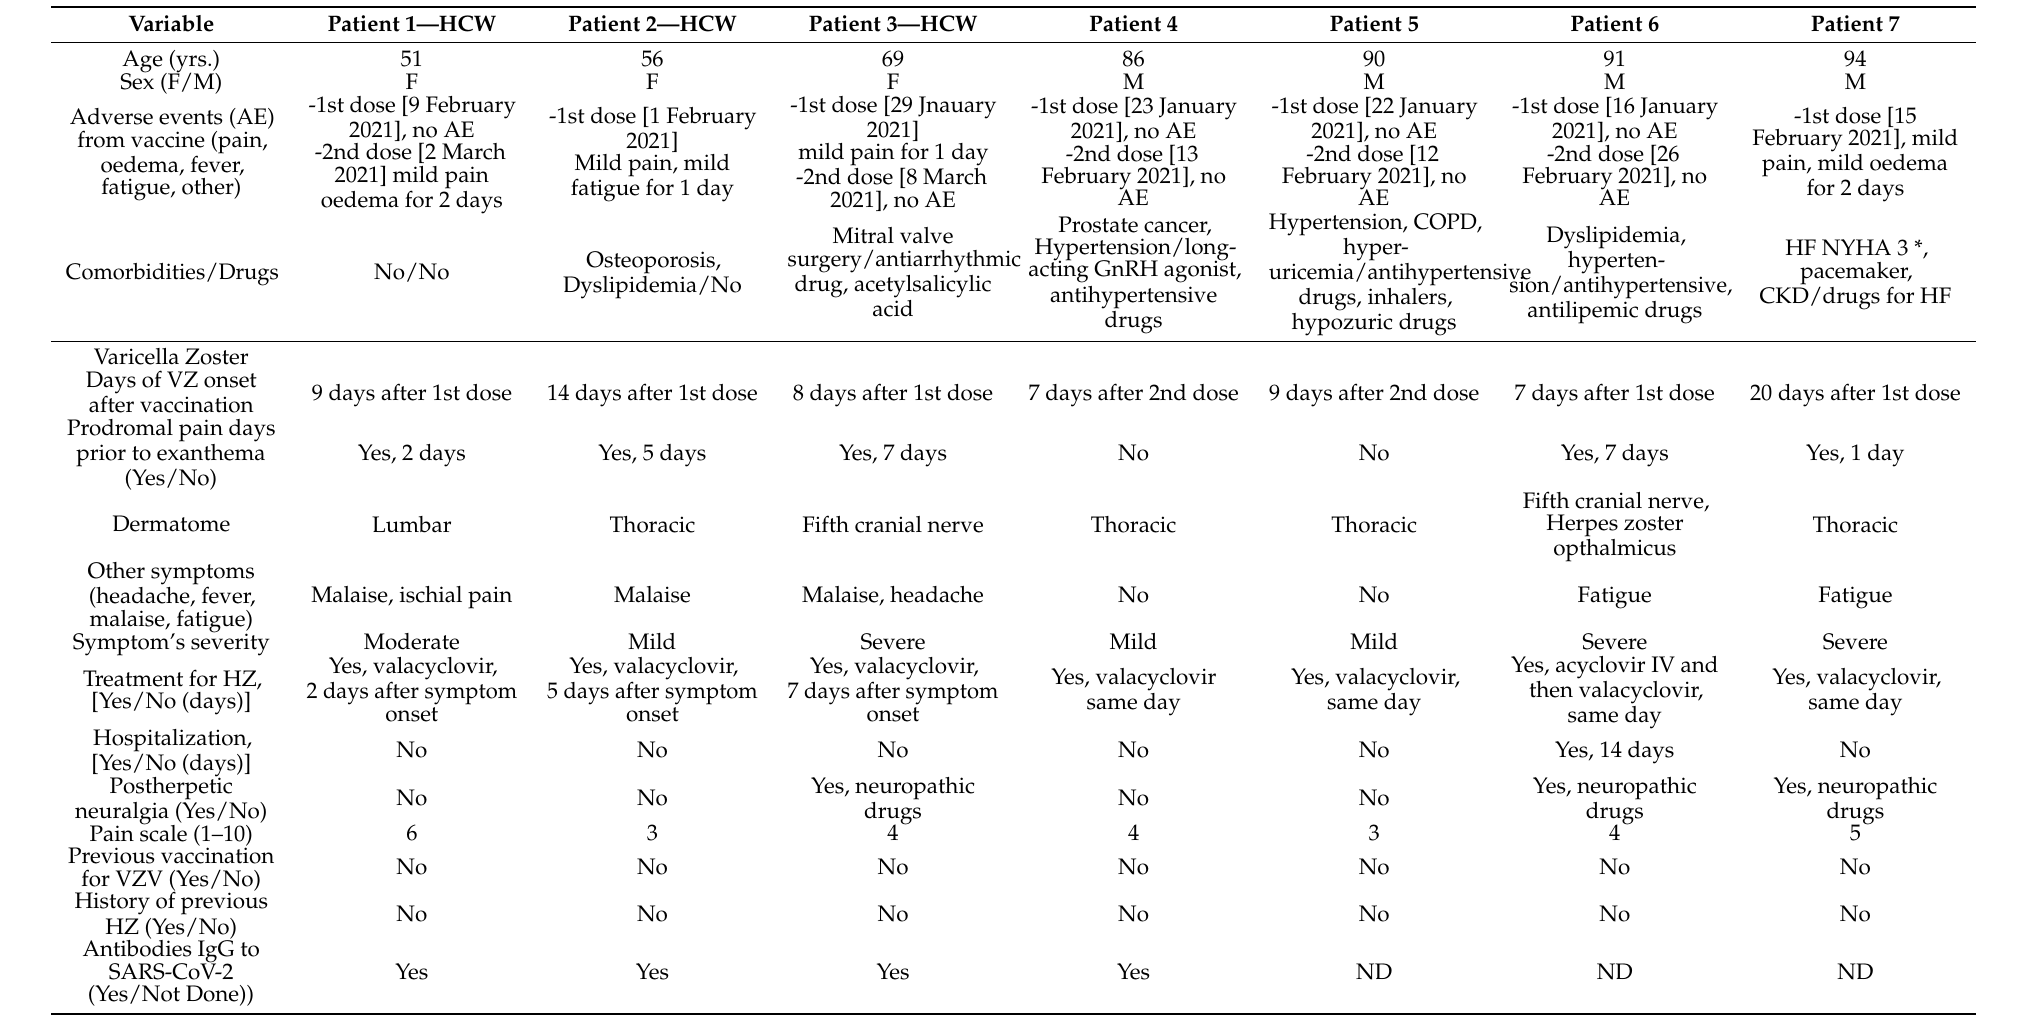
Table 1. Demographics, SARS-CoV-2 vaccination timing and side effects, varicella zoster characteristics and management of reported